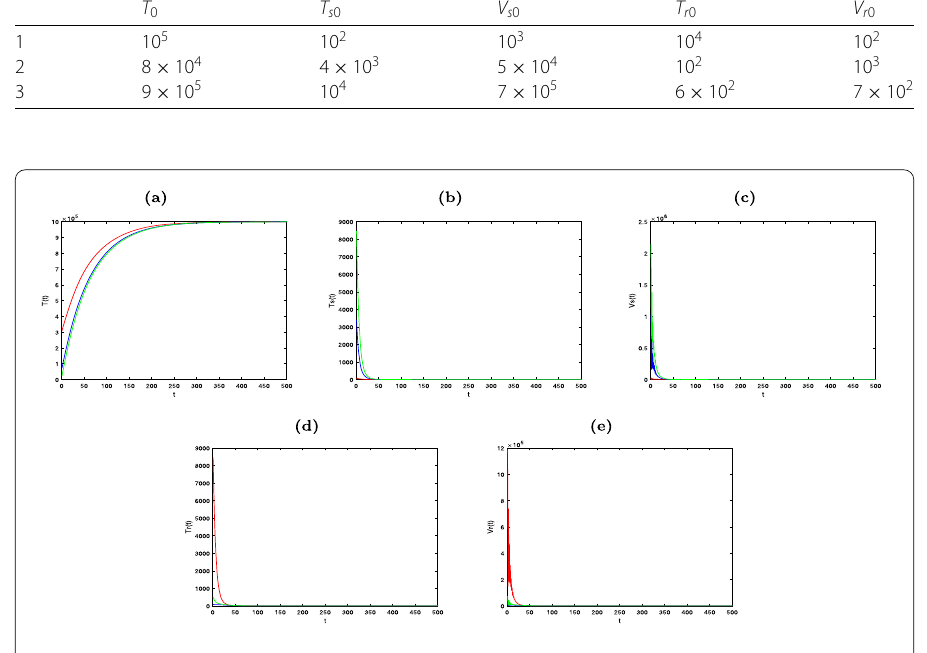
Figure 2 ( a ) Dynamical behaviors of uninfected target cells; ( b ) Dynamical behaviors of infected cells infected by wild-type virus; ( c ) Dynamical behaviors of drug-resistant virus; ( d ) Dynamical behaviors of infected cells infected by wild-type virus; ( e ) Dynamical behaviors of drug-resistant virus